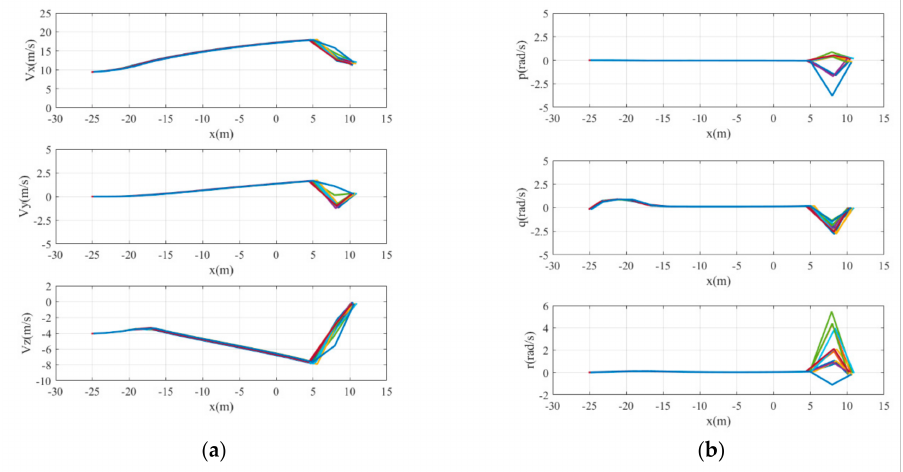
Figure 15. The UAV states under case 2. ( a ) global linear velocities. ( b ) body